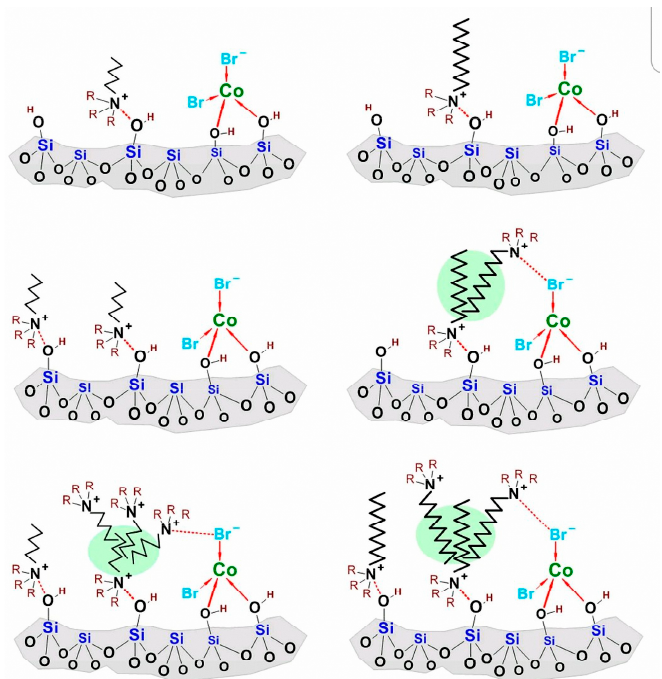
Figure 7. Inhibition of cobalt oxidation. The LEFT sequence represents small surfactants (tetraethyl ammonium bromide and triethyl hexyl ammonium bromides). The RIGHT sequence represents surfactant with higher number of carbon (dodecyl trimethyl ammonium bromide). The concentration of surfactant increases from the top to the bottom. Local aggregation is evidenced by the green area. Reprinted with permission from [100]; Copyright 2014 Copyright The Royal Society of Chemistry.